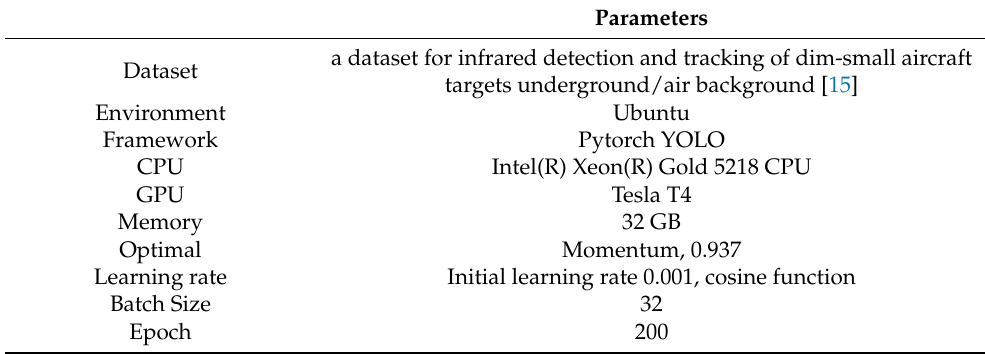
Table 1. Experimental environmental parameters.